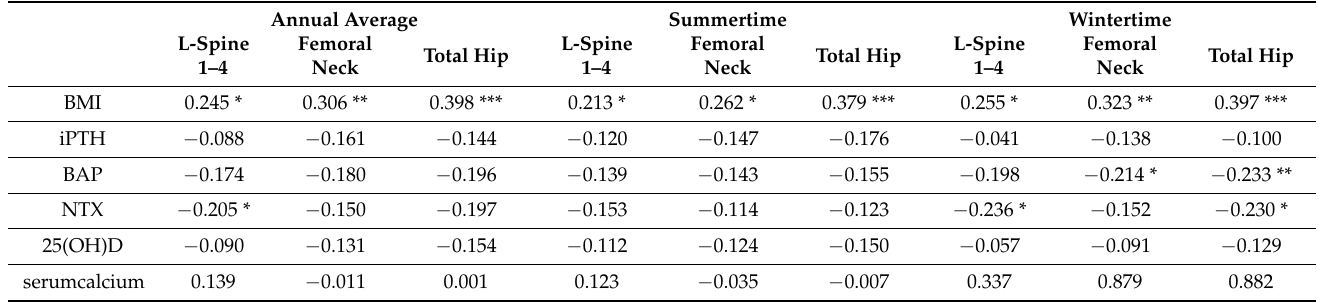
Table 2. Correlation coefficients of body mass index, biochemical indices, and bone mineral density.